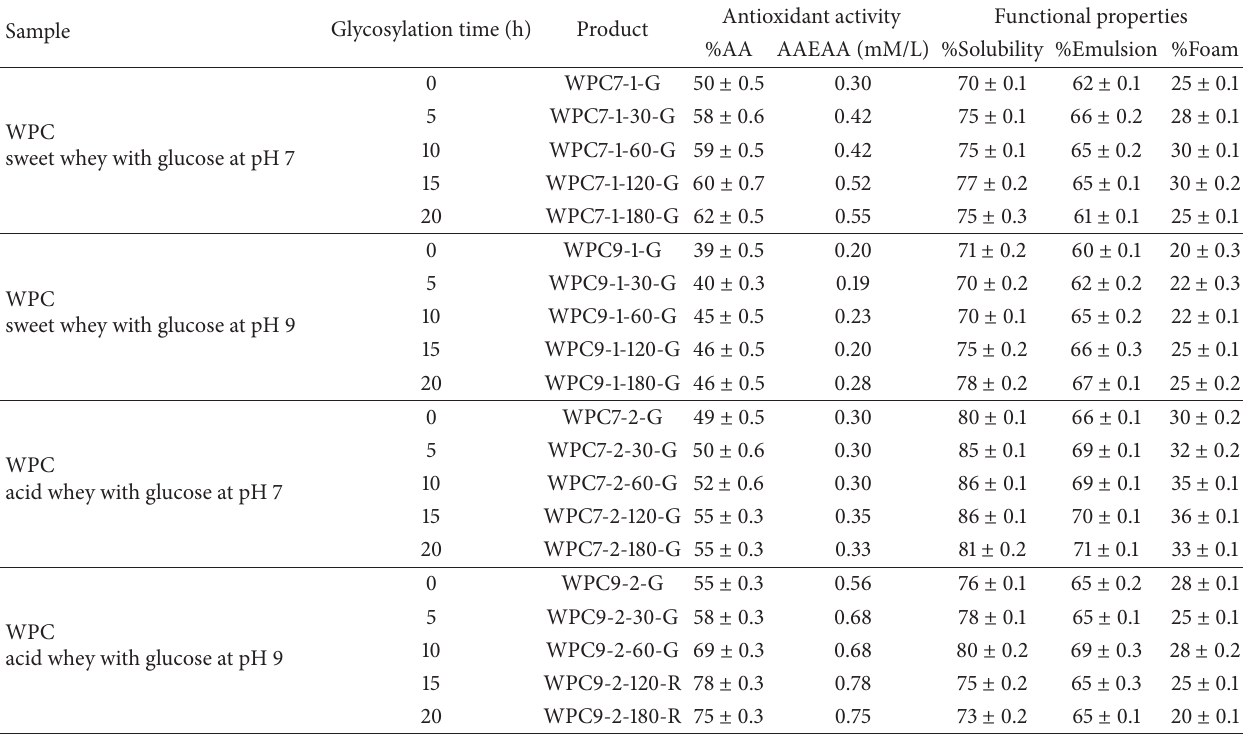
Table 4: Features of glycosylated product from WPC of sweet whey with glucose and heating to 50 ∘ C, pH 7 and pH 9.